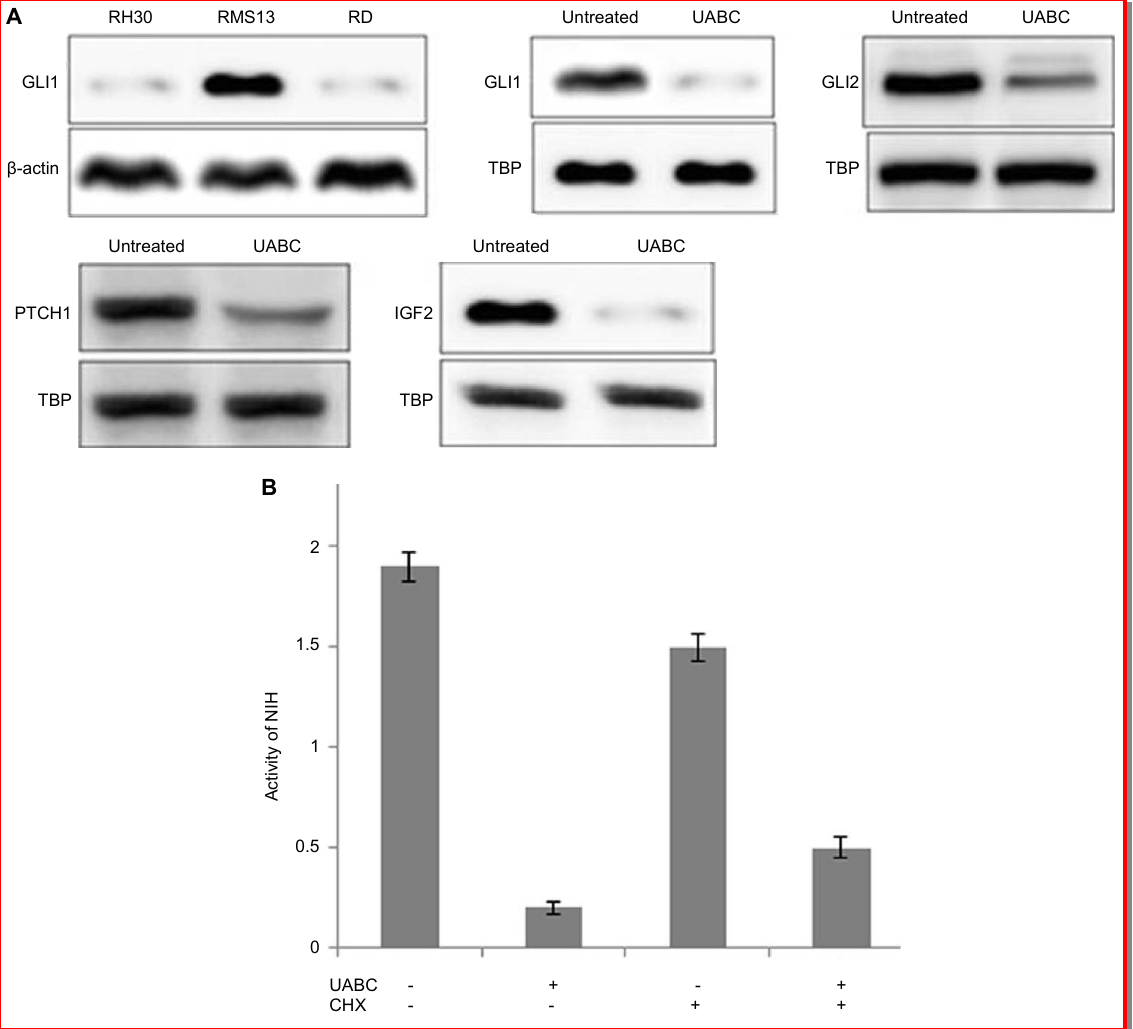
Figure 5: (A) UABC blocks hedgehog signalling, GLI1 expression of rhabdomyosarcoma cell lines. The RMS cell lines were lysed and the expression of GLI1 and β - actin was detected by western blot analysis. For hedgehog signalling dependency, the RMS cells were treated for 48 hours with UABC. GLI1, GLI2, PTCH1, and IGF2 mRNA expression from untreated and treated RMS cells was measured by quantitative real-time PCR in relation to the house-keeping gene TBP as a calibrator. (B) Hedgehog pathway activity. The RMS-13 cells were transiently transfected with 900 ng hedgehog-responsive reporter plasmid (p11 x Gli) or control plasmid (pGL3-TK) and treated for 24 hours with UABC and 10 μ M cyclopamine or vehicle. Reporter assay experiments were repeated three times and transfections performed in